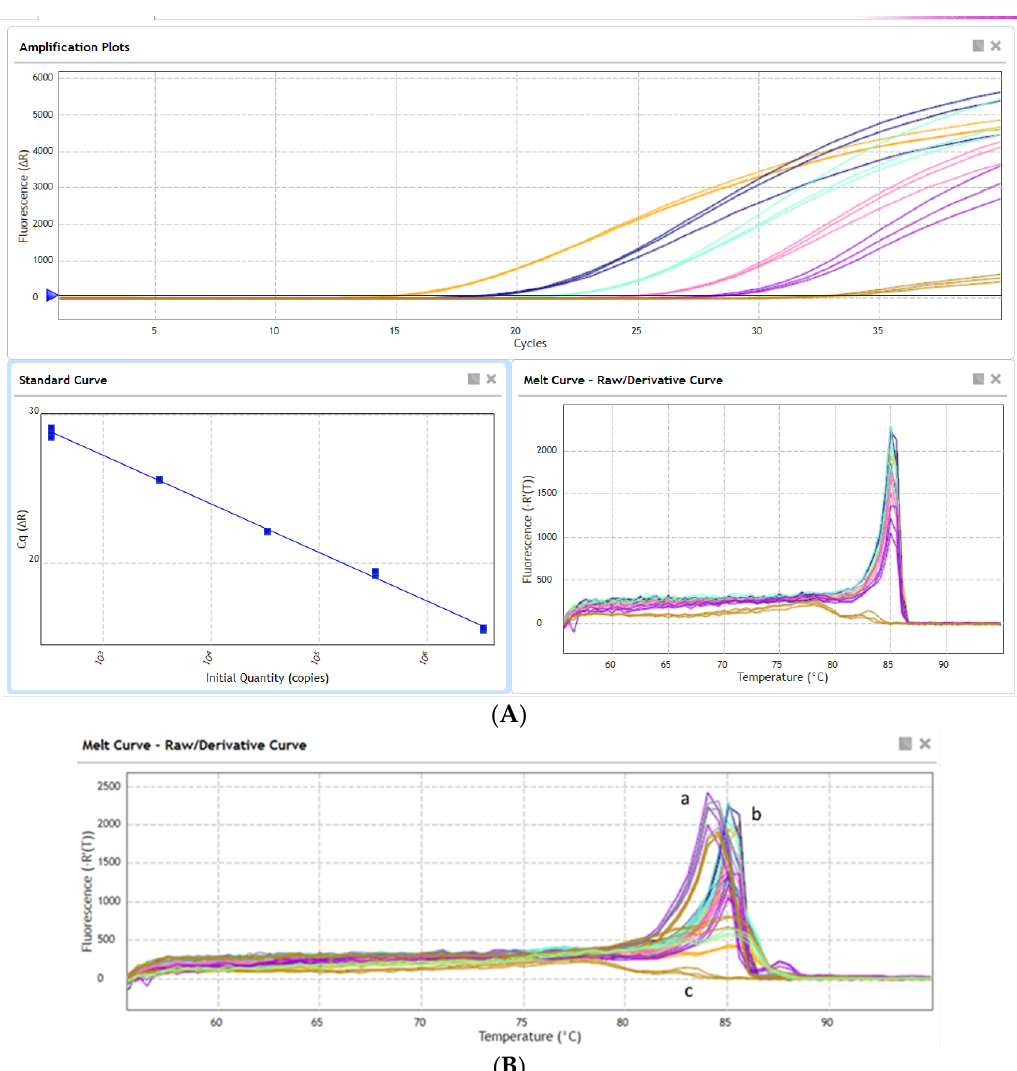
Figure 4. ( A ) Amplification plots and melting curves (AriaMX platform) from a Neocallimastix cameroonii (YoDo11) pure culture as the standard curve and NTC controls (brown color) showing no inhibition as all dilutions cross the fluorescence threshold with a difference of about 3 cycles and a melting temperature of 85.0 °C. ( B ) Melting curve plots with primer pair AGF-LSU-EnvS from DNA extracts of Neocallimastix cameroonii (YoDo11, standard curve), cow, elephant, lama and, mara feces. The dissociation curve generated by DNA from mara feces (a) peaked at 84.5 °C, whereas the curves of the other DNAs peaked at 85.0 °C (b), and the NTC (c, in a brown color) showed no peak. The copy number of Neocallimastigomycetes LSU DNA in environmental samples var- ied from 8.3 × 10 8 copies per gram fresh weight (FW) in lama feces, to 1.5 × 10 11 copies/g FW in mara feces. For the AGF cultures, between 1.4 × 10 11 copies/g FW for Feramyces austinii DF1 and 3.0 × 10 12 copies/g FW for Buwchfawromyces eastonii GE09 were obtained. The average of the LSU copy number of the four environmental (fecal) samples was at 5.6 × 10 10 copies/g FW (SD = 1.5 × 10 10 ), meanwhile the pure cultures averaged at 7.8 × 10 11